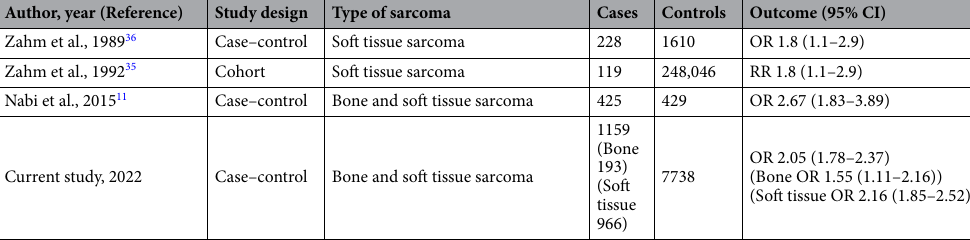
Table 8. Outcomes for the incidence of sarcomas by smoking in previous studies. CI Confidence interval, OR Odds ratio, RR Relative risk.